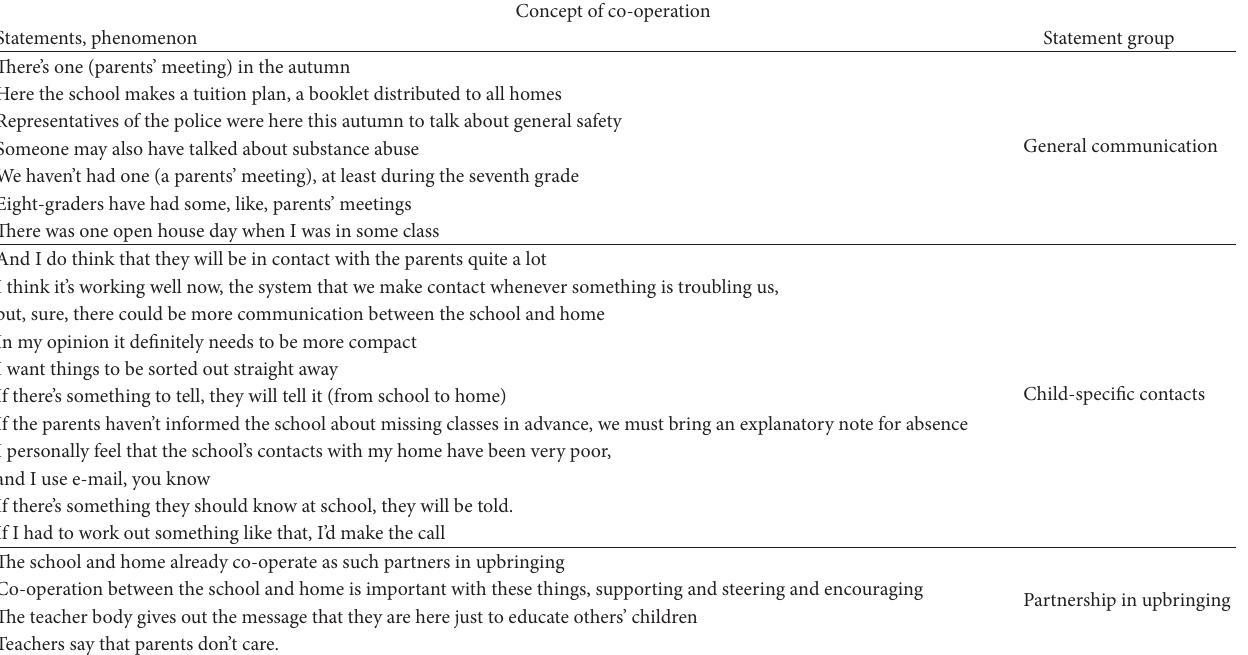
Table 1: Example of statement